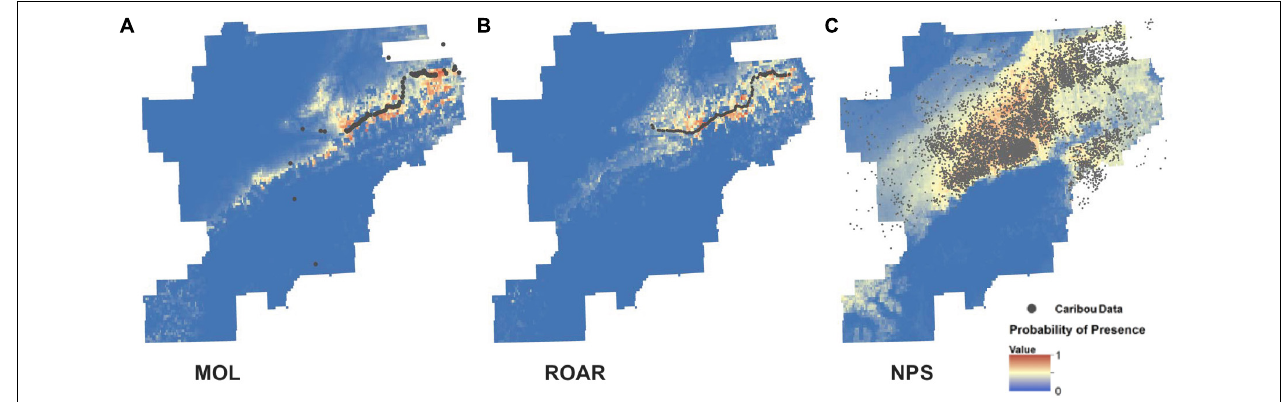
FIGURE 10 | SDM made with caribou data. (A) The distribution of the MOL collected caribou data. (B) The ROAR data. (C) The NPS radio collar collected data. Areas of warmer colors have a higher probability of caribou